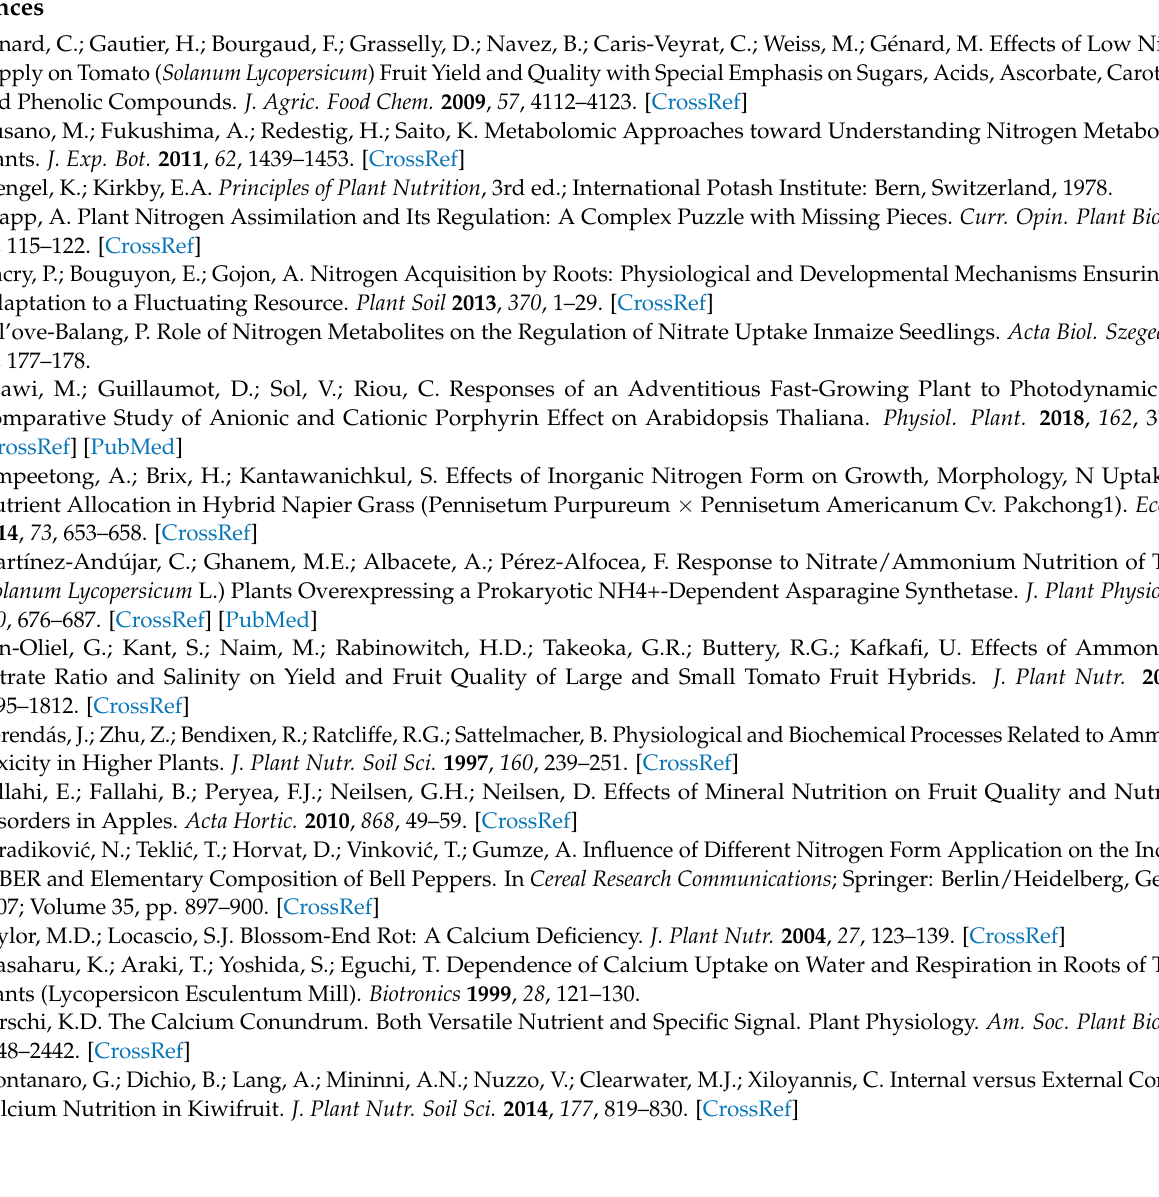
Table S4: Nutritional data from in vitro experiment used for PCA analysis. Table S5: Nutritional data from potted plants used for PCA analysis. Table S6: Normalized nutritional and phenotypic data used for PCA